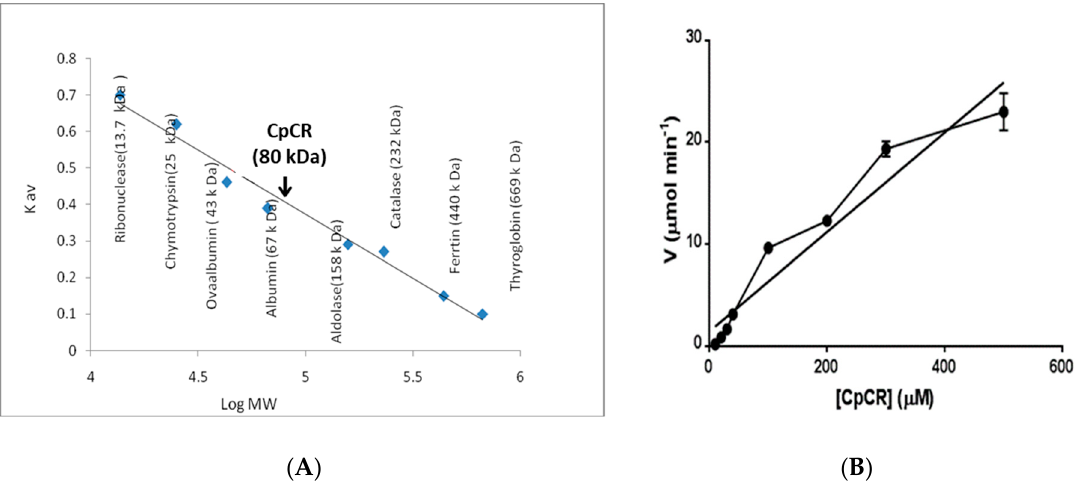
Figure 1. Oligomeric state of CpCR. ( A ) A plot of Log Mol. Wt. vs. K av shows the calibration curve of the known standards including and the molecular weight of CpCR; ( B ) A plot of velocity of reaction vs. micro molar concentration of CpCR.